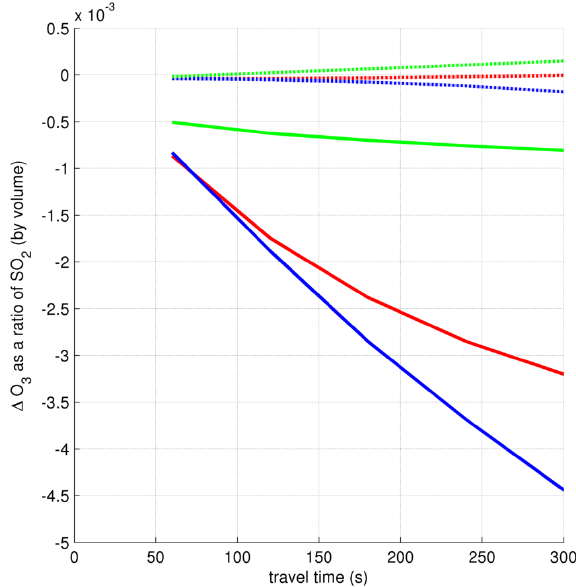
Figure 8. Evolution of (cid:49) O 3 / SO 2 in the core of the plume for the six model scenarios discussed in the text (“low Br / S” initialisa- tion). The colour code is the same as in Fig.